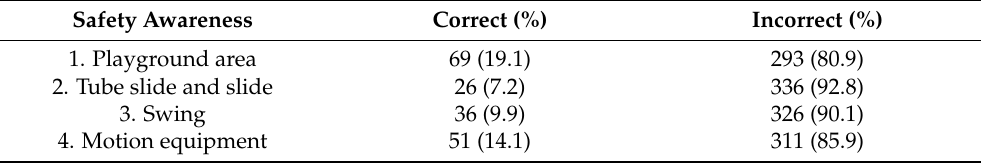
Table 2. Safety awareness of playground and playground equipment ( n = 362).